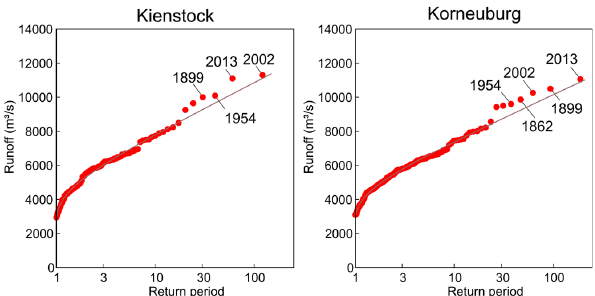
Fig. 11. Statistical analysis of annual maximum runoff for Kien- stock (95970km 2 , left) and Korneuburg (101536km 2 , right). Lines show fitted Gumbel distributions. Kienstock data 1893–2013, Ko- rneuburg data 1828–2013. Kienstock is a combined series with the nearby Stein–Krems gauge; Korneuburg is a combined series with the nearby Vienna